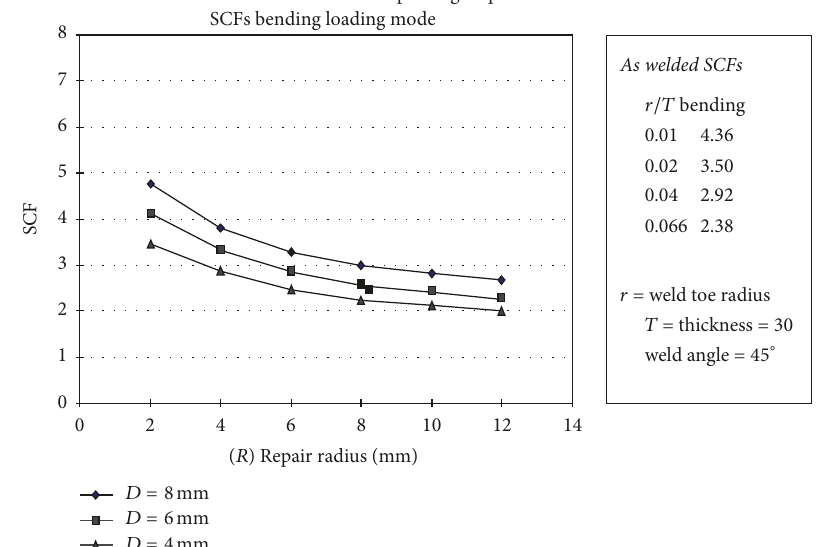
Figure 15: Stress concentration factors for a T-butt with semicircular and U-shaped edge repairs under bending loading [19].